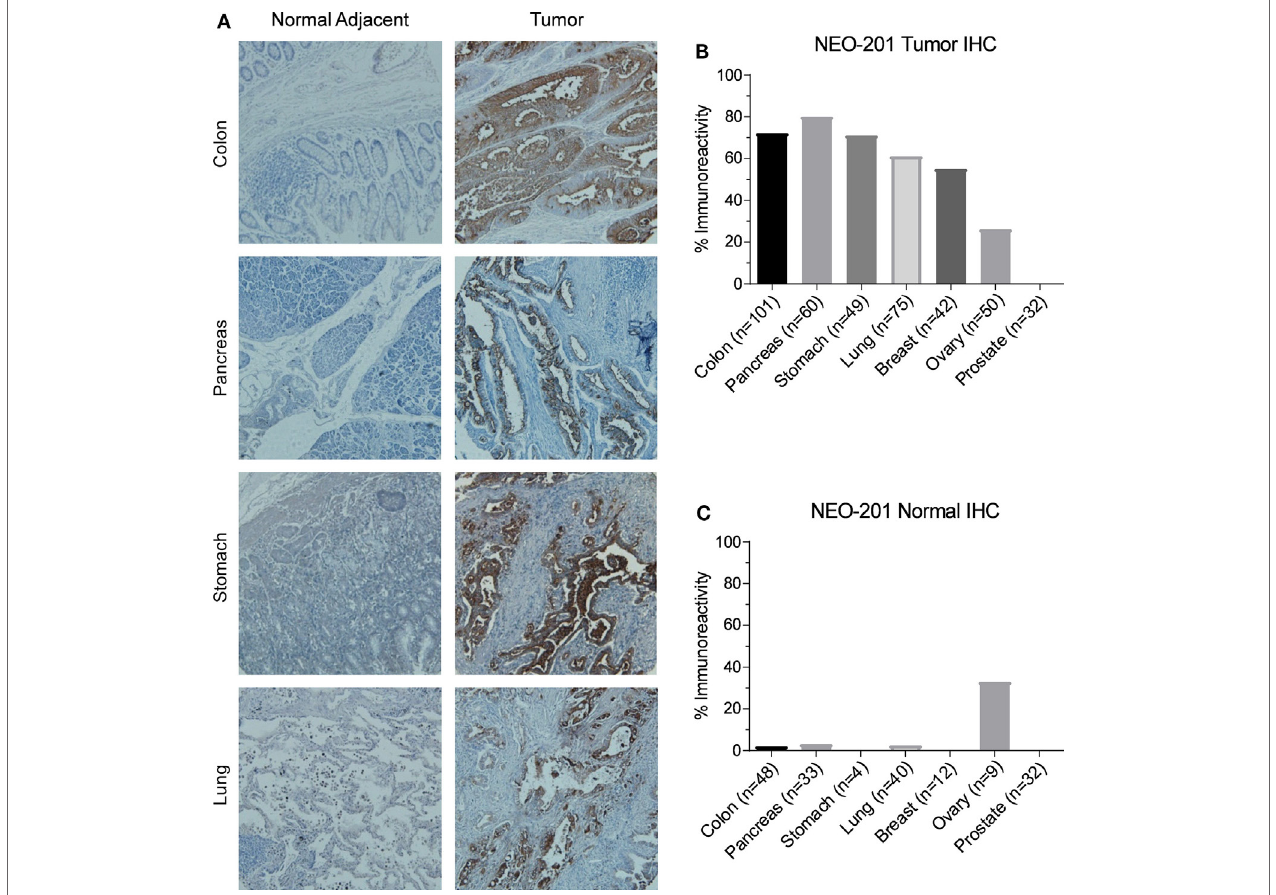
FigUre 2 | Immunohistochemistry (IHC) staining of human tumor samples by NEO-201. (a) Representative NEO-201 staining from normal and malignant tissues from colon, pancreas, stomach, and lung samples. All images were obtained at 100 × . (B) Quantification of NEO-201 positive staining from the human tumor microarray samples from various carcinoma tissues. (c) Quantification of NEO-201 positive staining from normal tissue included in the human tumor microarray samples. n , number of samples.